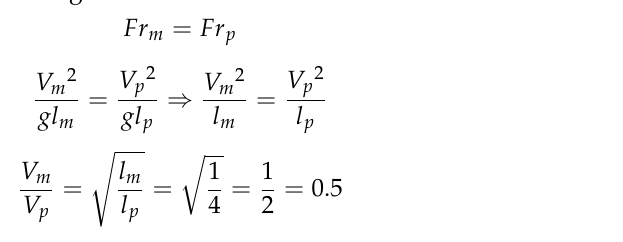
Figure 3. Dimensions and geometries of SEN. Table 2. Parameters of the water model and the corresponding full-scale steel caster. Parameter